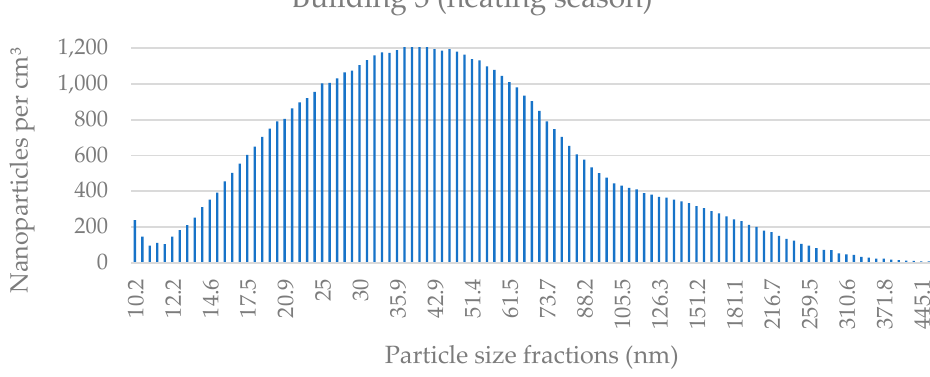
Figure A4. The average nanoparticle concentration in each size fraction in Building 2 during a one- week measurement period during the nonheating season.